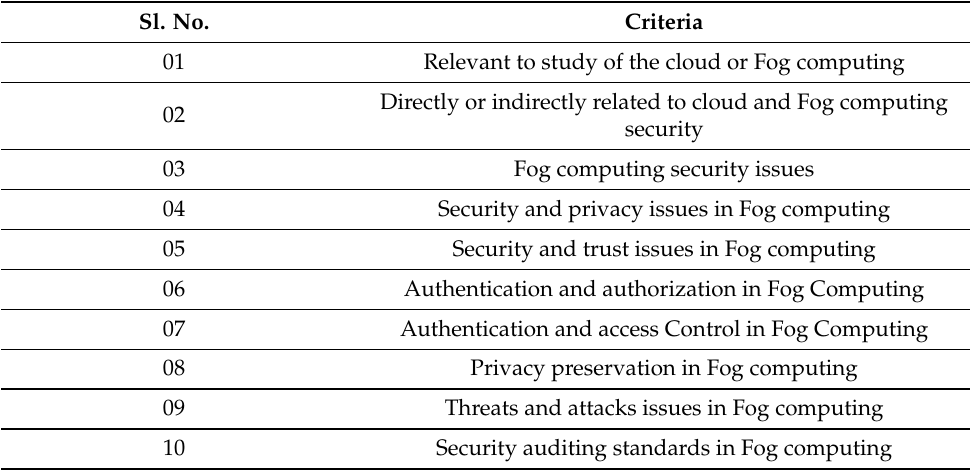
Table 2. Paper selection